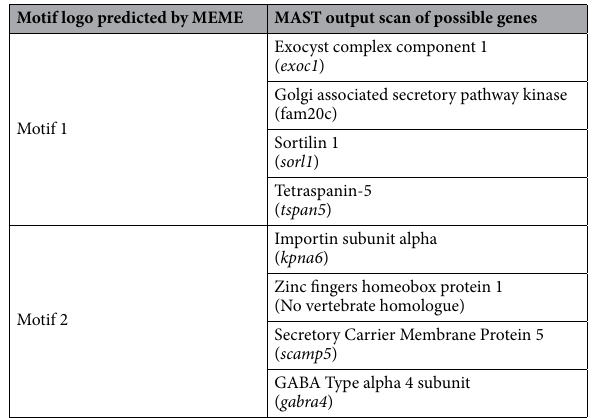
Table 2. MEME/MAST motif identification and scanning resulted in a number of prominent motifs identified in the top TM penetrating peptides. Pattern analysis using the peptides sequences from Table 2 reveled the two featured conscience motifs. The sequence logos are depicted in the first column and the top MAST output hits (E-value > 10) are presented.